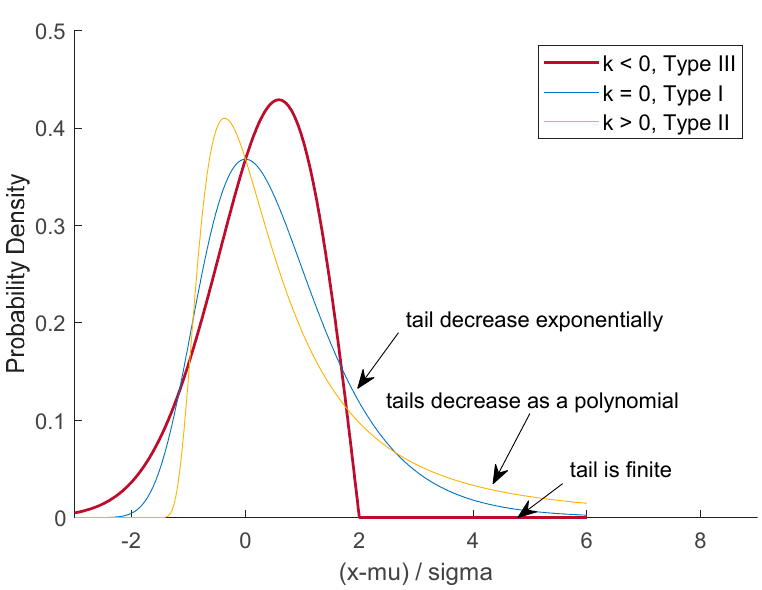
Figure 8. An example for three types of extreme value distributions and their tails’ features.